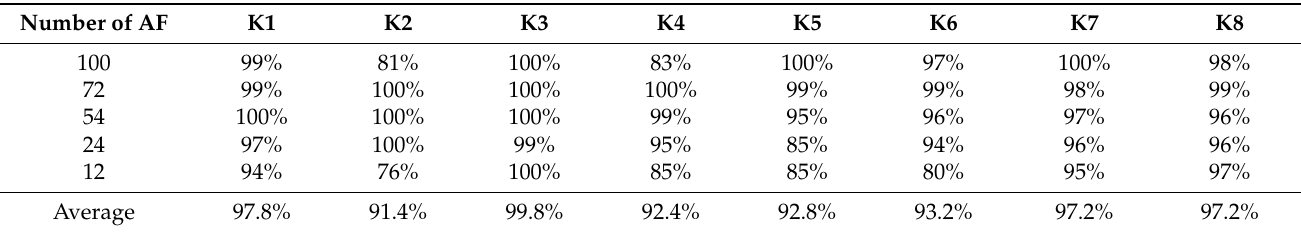
Table 9. Average tracking success rate of random deployment in target